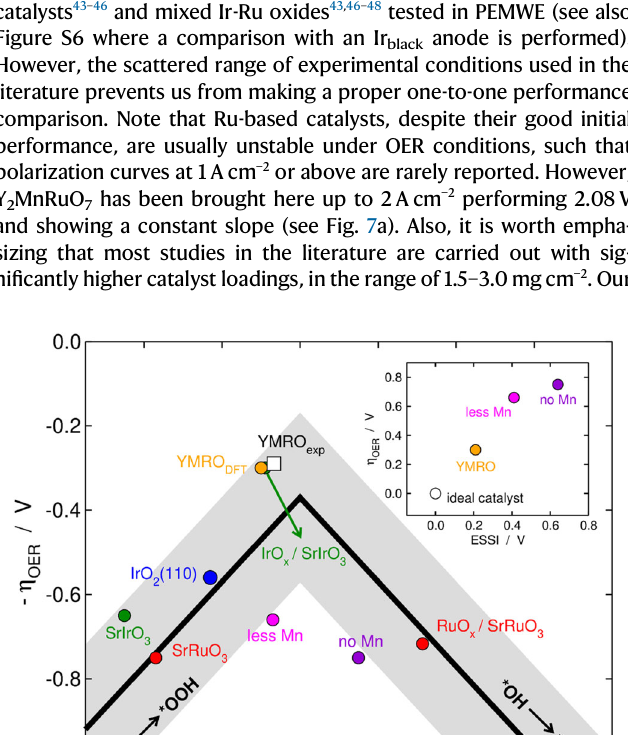
the experimental data from Fig. S2c adapted using a method reported elsewhere 16,66 , see section S1.2. Inset: OER overpotential as a function of the electrochemical-step symmetry index (ESSI) for different Ru-containing catalysts. The ideal catalyst, which has Δ G i =1.23eV and η OER =0V, is provided for comparison.